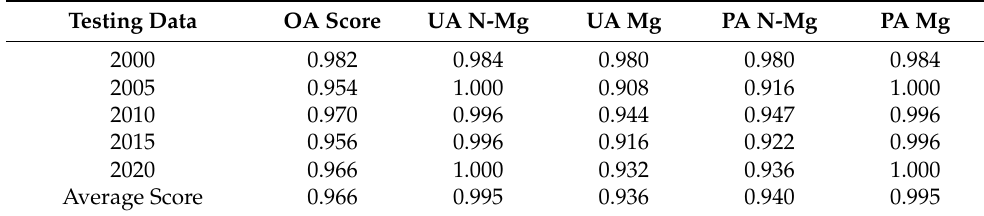
Table 6. The average of evaluation assessment in the year of 2000, 2005, 2010, 2015 and 2020. Testing Data